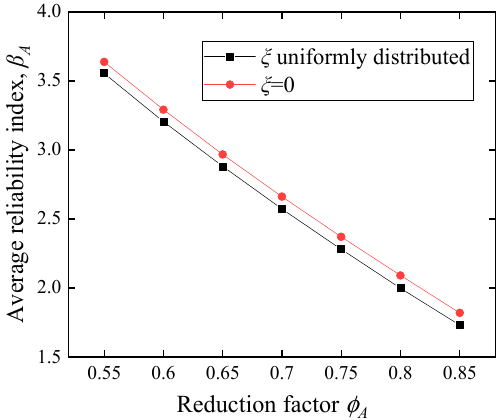
Figure 17. Effect of ξ on the average reliability index. Table 5. The probability of calculation case.